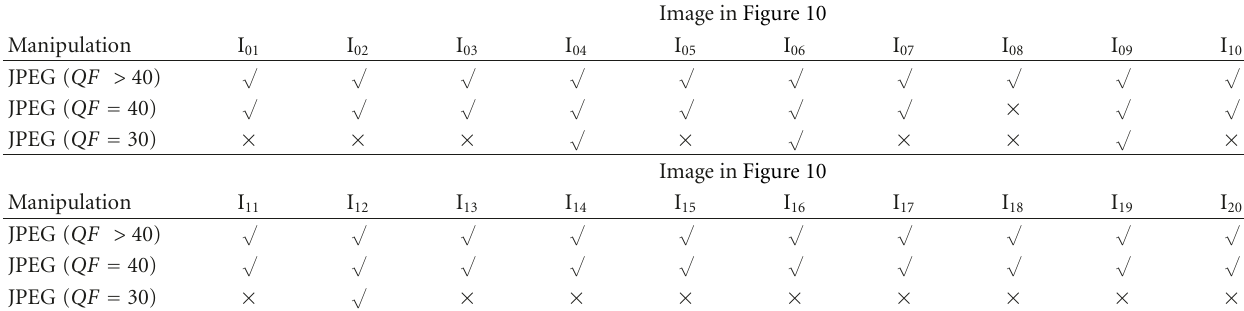
√ means that our scheme